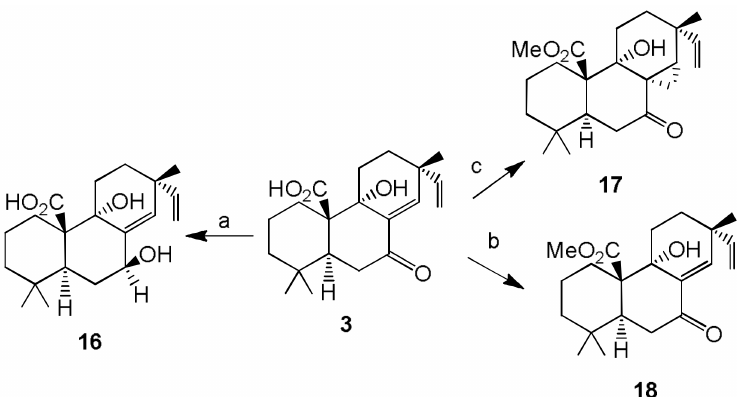
Scheme 3. The structures of sphaeropsidin C ( 3 ) and its derivatives ( 16 – 18